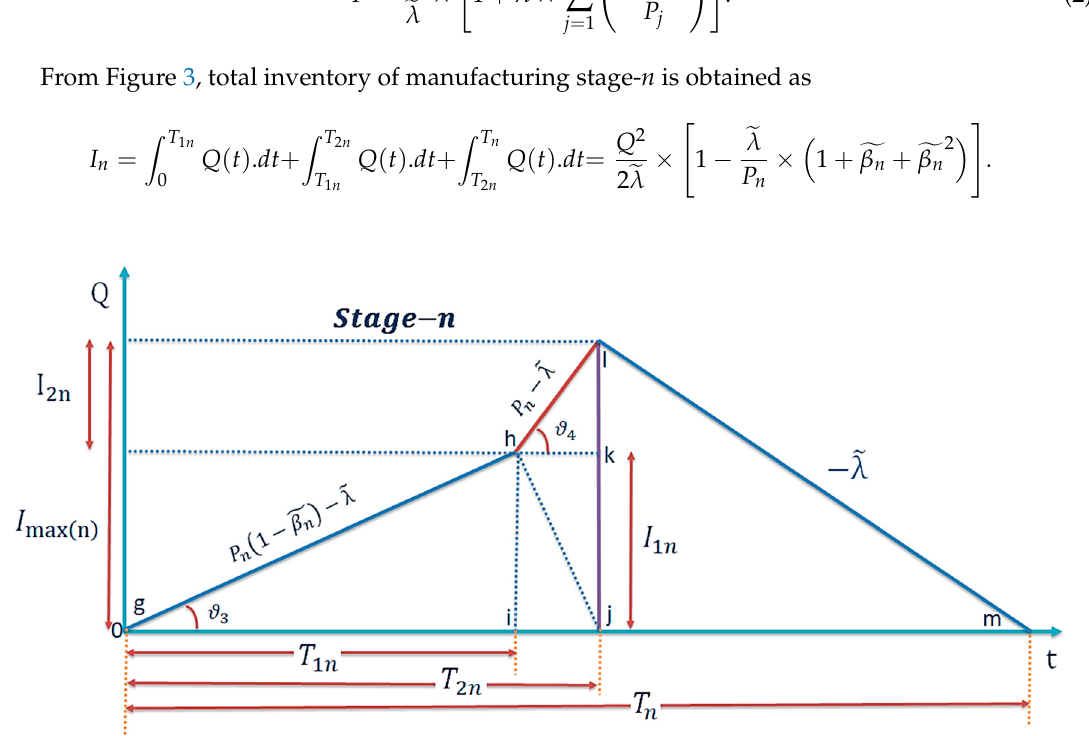
Figure 3. Inventory behavior of stage- n (reference: Tayyab and Sarkar [12]).